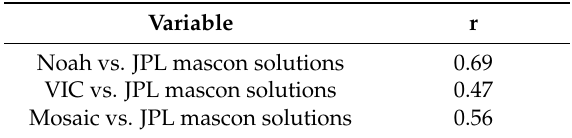
Table 3. Correlation coefficients of different hydrological models and JPL mascon-based TWSA (n = 168).